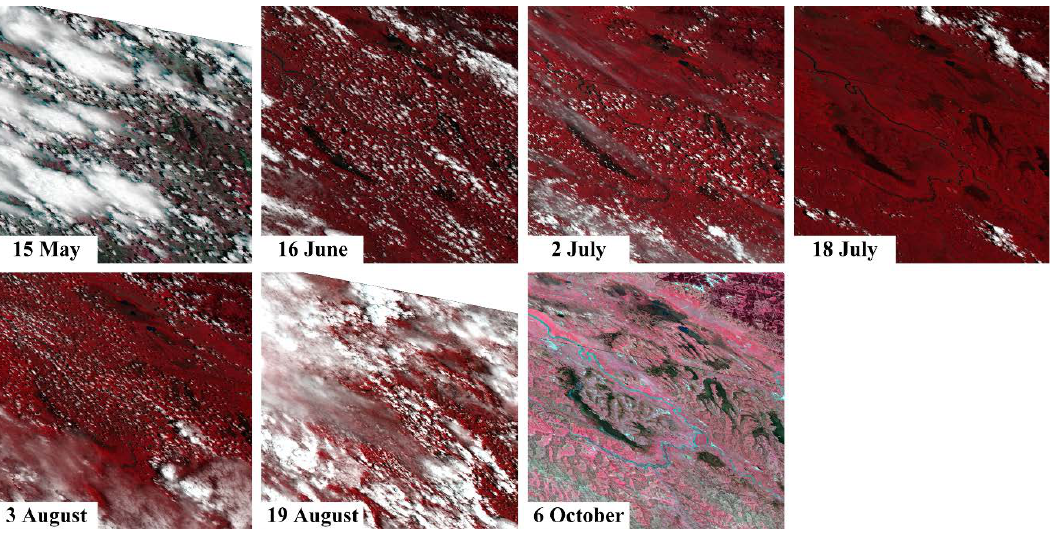
Figure 2. Composited Landsat OLI 8 images covering the study area in 2017.